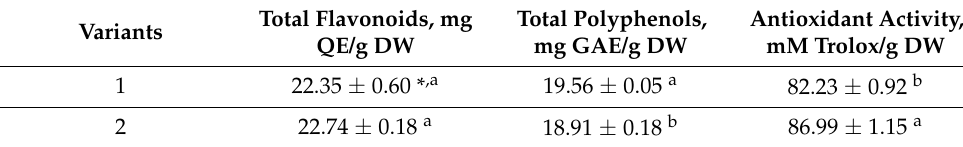
Table 2. Phytochemical stability in the powders during storage. Total Flavonoids, Variants